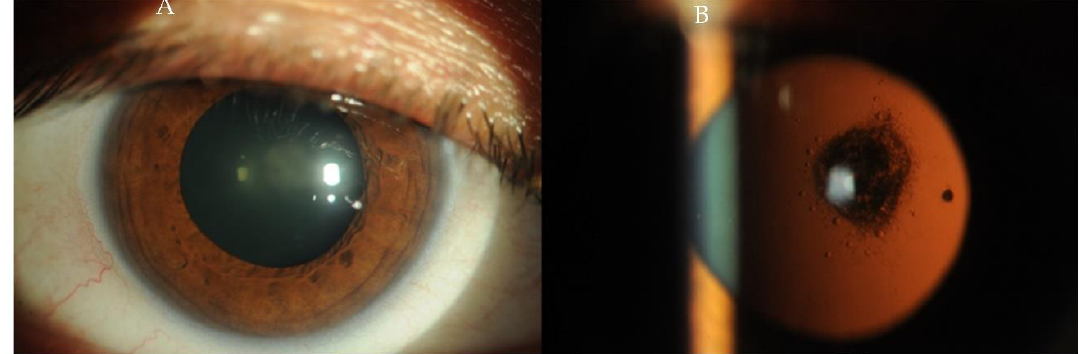
Figure 4. ( A , B ) Photographs of the anterior segment of the eye of a patient with posterior subcapsular cataract in the course of SLE.